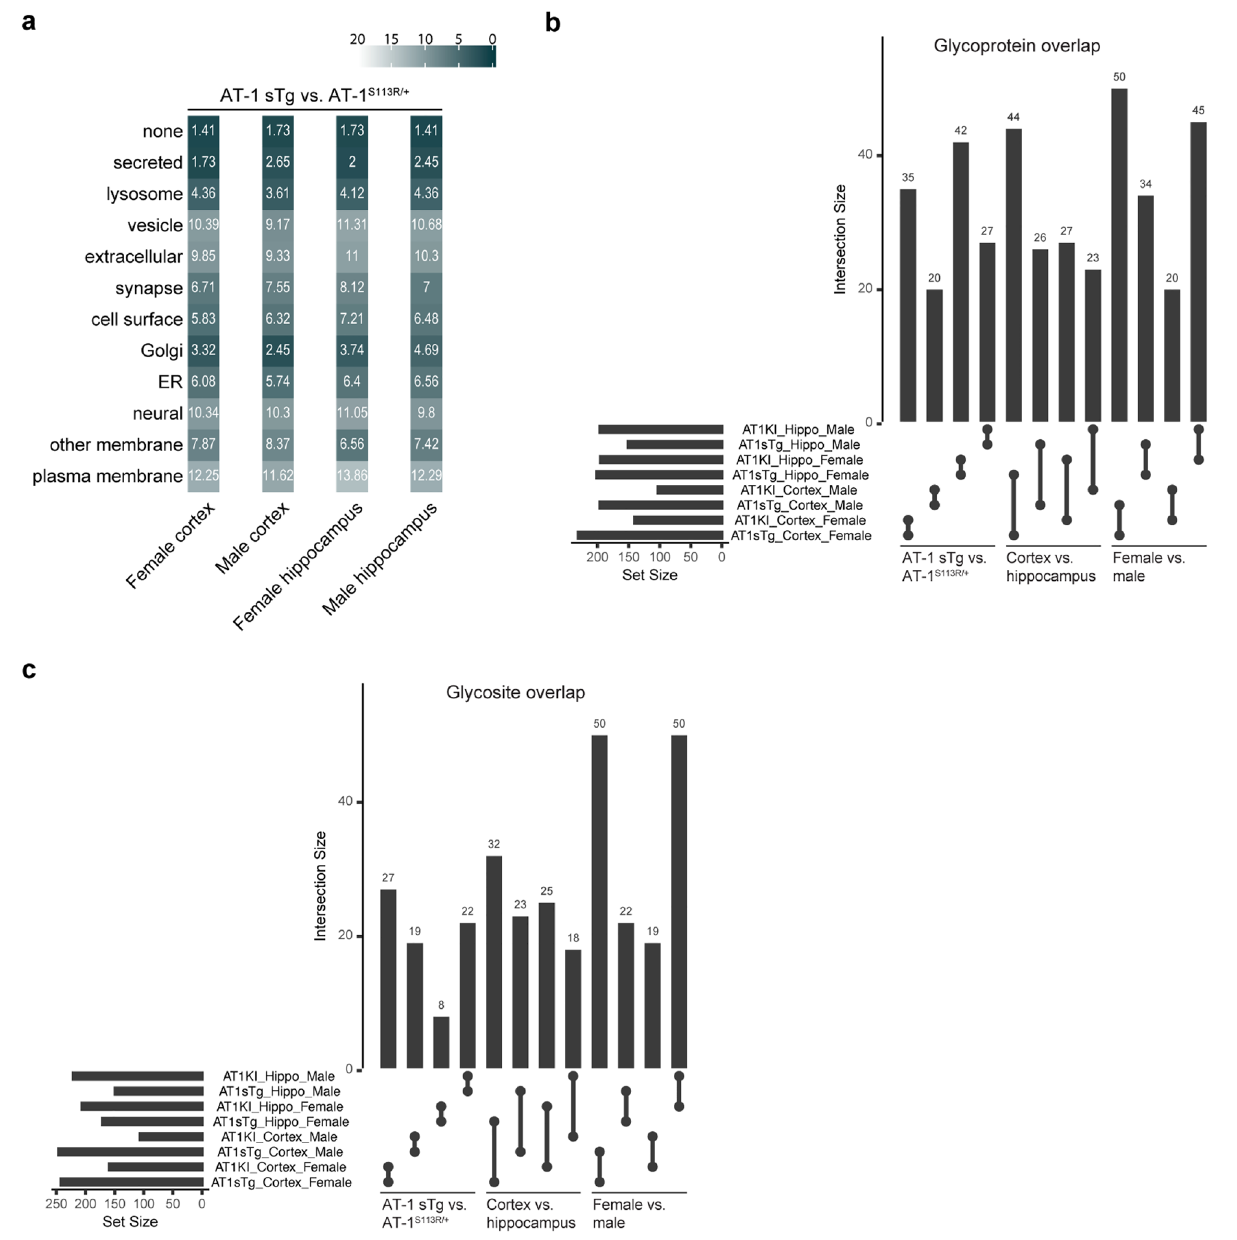
Figure 6. AT-1 sTg and AT-1 S113R/+ display both divergent and convergent N-glycoproteomic changes across subcellular locations. ( a ) Euclidean distances comparing the distance between significant glycoforms found in AT-1 sTg and AT-1 S113R/+ , broken down by sex and brain region. Distances were calculated according to their subcellular locations, with higher similarity indicated with dark colors. ( b , c ) Significant glycoprotein ( b ) and glycosite ( c ) overlap is examined at the level of model (AT-1 sTg v. AT-1 S113R/+ ), brain region (cortex vs. hippocampus) and sex (female vs. male). The upper bar graph indicates the size of intersection and the left bar graphs shows total number of significant glycoproteins ( b ) or glycosites ( c ) in each Overexpression of AT-1 in cellular systems is accompanied by increased incorporation of O-propargyl- puromycin and azide-modified mannosamine, highlighting both increased protein biosynthesis and increased terminal sialylation 5,6 . Furthermore, neuronal overexpression of AT-1 caused a significant expansion of the proteome with 476 proteins found to be upregulated; an effect that was connected to the expansion of the den- dritic and synaptic network 5 . The results described here suggest that in AT-1 sTg the expansion of the ER and the ERGIC, together with the increase in ER-to-Golgi transport of cargo material is not paralleled by compensa- tory changes within the Golgi apparatus to ensure post-translational N-glycosylation. It is also possible that the increased availability of acetyl-CoA within the ER, as caused by overexpression of AT-1 might affect the activity and specificity of the ATases thus resulting in incorrectly folded glycoproteins to be acetylated and forced to transition toward the Golgi apparatus. Indeed, individual acetyltransferases possess different K m values within